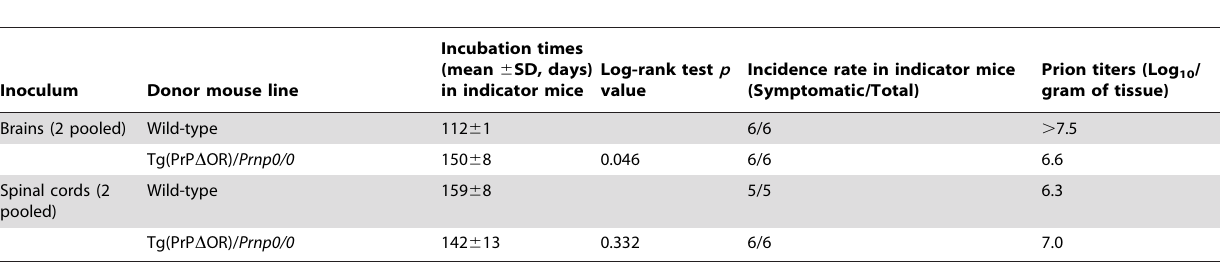
Table 3. Prion titers in the brains and spinal cords of terminally ill tg(PrP D OR)/ Prnp 0/0 and wild-type mice inoculated with RML